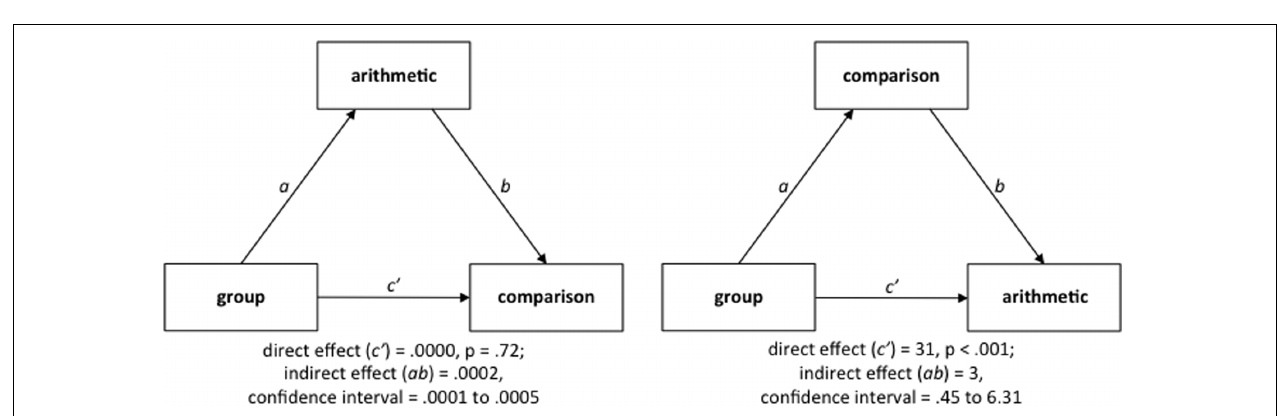
FIGURE 2 | Mediation models. (Left) Model testing whether performance in the arithmetic tasks mediates the association between the factor group (Chinese vs. German) and reciprocal RT in the symbolic numerical magnitude comparison task. (Right) Model testing whether reciprocal RT in the symbolic numerical magnitude comparison task mediate the association between the factor group (Chinese vs. German) and performance in the arithmetic tasks.